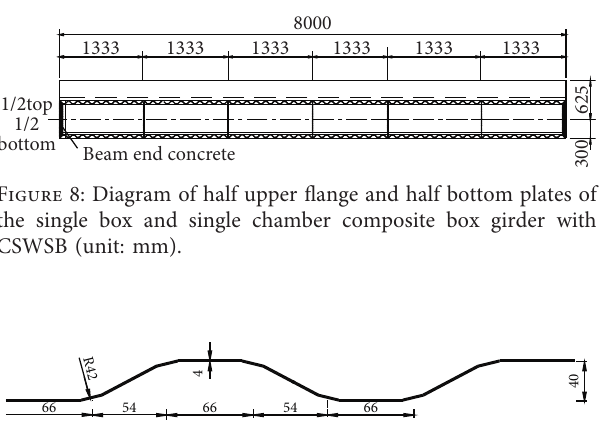
Figure 9: Structural diagram of corrugated steel web (unit: mm).